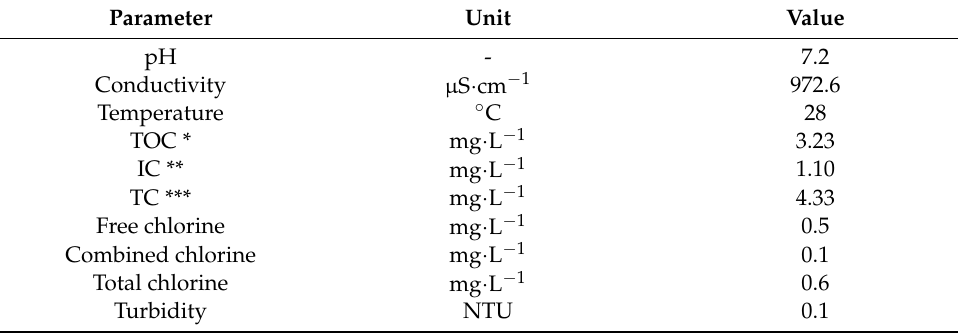
Table 1. Characteristics of the model swimming pool